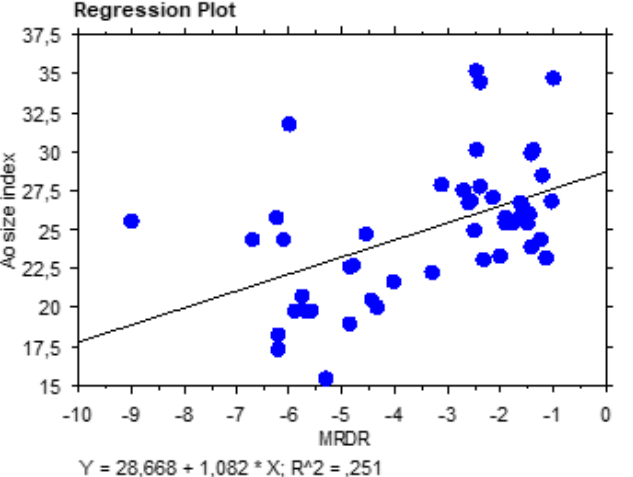
Fig. 4 – Regression plot showing a significant correlation between maximal rate of diastolic recoil (MRDR) and aortic size index.